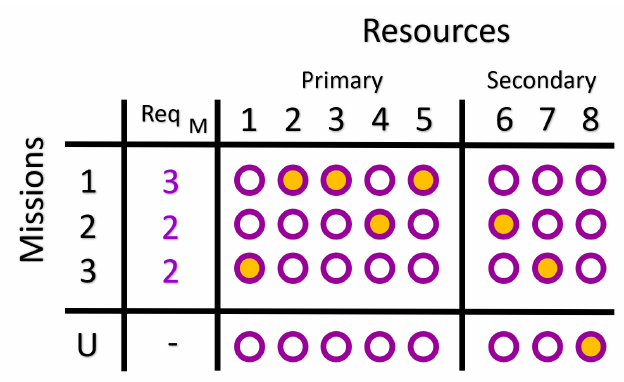
Figure 1. Matrix view for Solution: This represents a table representing the solution of a problem with three missions, five primary resources and three secondary resources. A purple circle symbolizes a Boolean variable x m , r ∈ { 0,1 } where m represents the mission (row) while r represents the resource (column). A circle filled in with orange represents x m , r = 1 and the fact that resource r is allocated to mission m